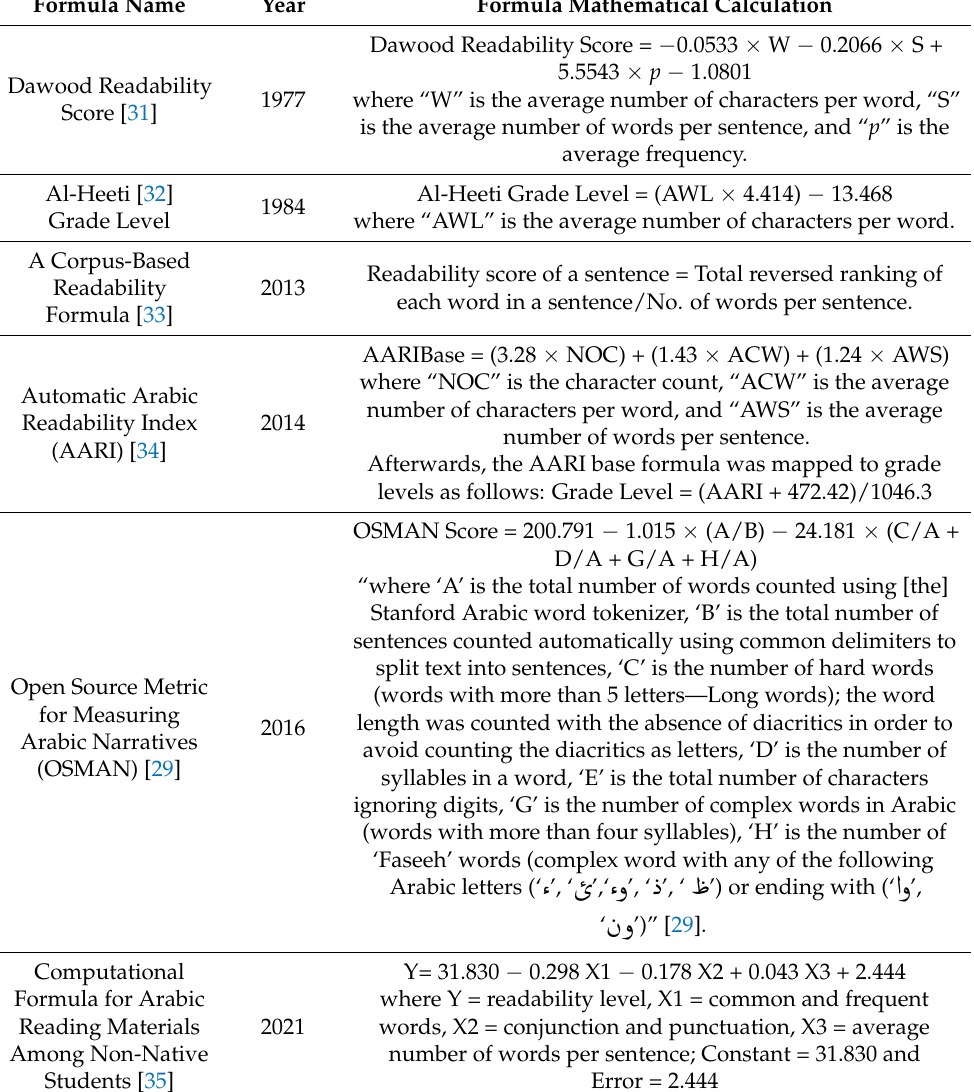
Table 1. Summary of readability formulas for